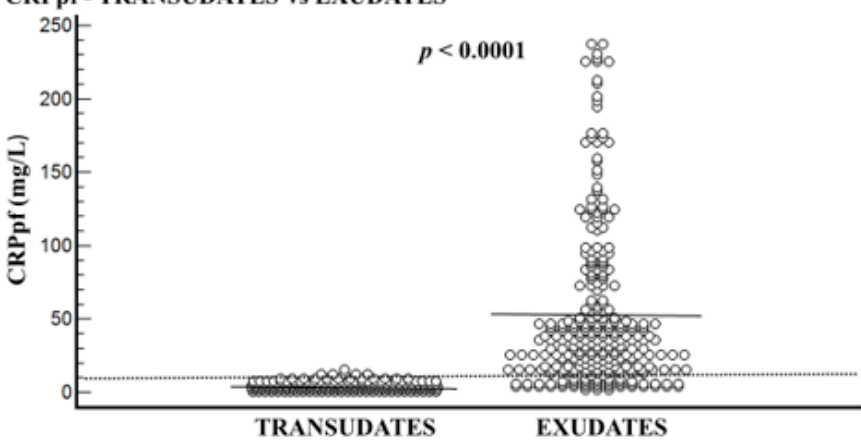
Figure 2. Pleural fluid CRP (CRPpf) levels and their means for transudate group (4.6 mg/L) and exudate group (52.8 mg/L), and best cut-off value (9.9 mg/L) for discrimination between the two groups. For both parameters p < 0.0001.